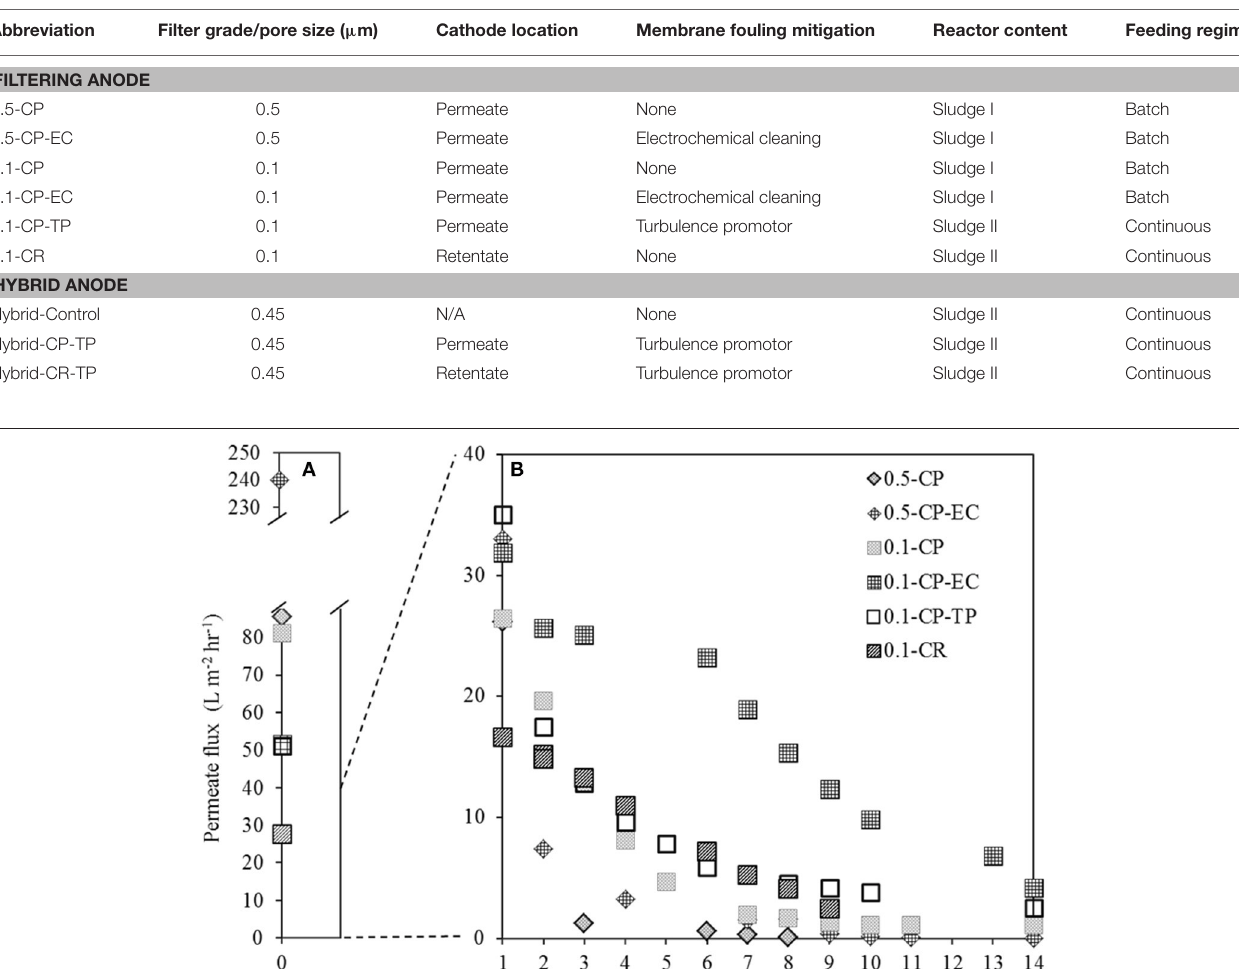
TABLE 1 | Overview of the experiments performed in two system configurations using stainless steel membranes of filter grades 0.1 and 0.5 µ m filtering anode; with electrochemical cleaning (EC) and turbulence promotor (TP) application as fouling mitigations methods, and the cathode located on the permeate side (CP) and retentate side (CR); and using polymeric membrane alone (Hybrid-Control) and polymeric membrane combined with a stainless steel mesh for hybrid anode configuration; with turbulence promotor (TP) application as fouling mitigation method, and the cathode located on the permeate side (CP) and retentate side (CR).